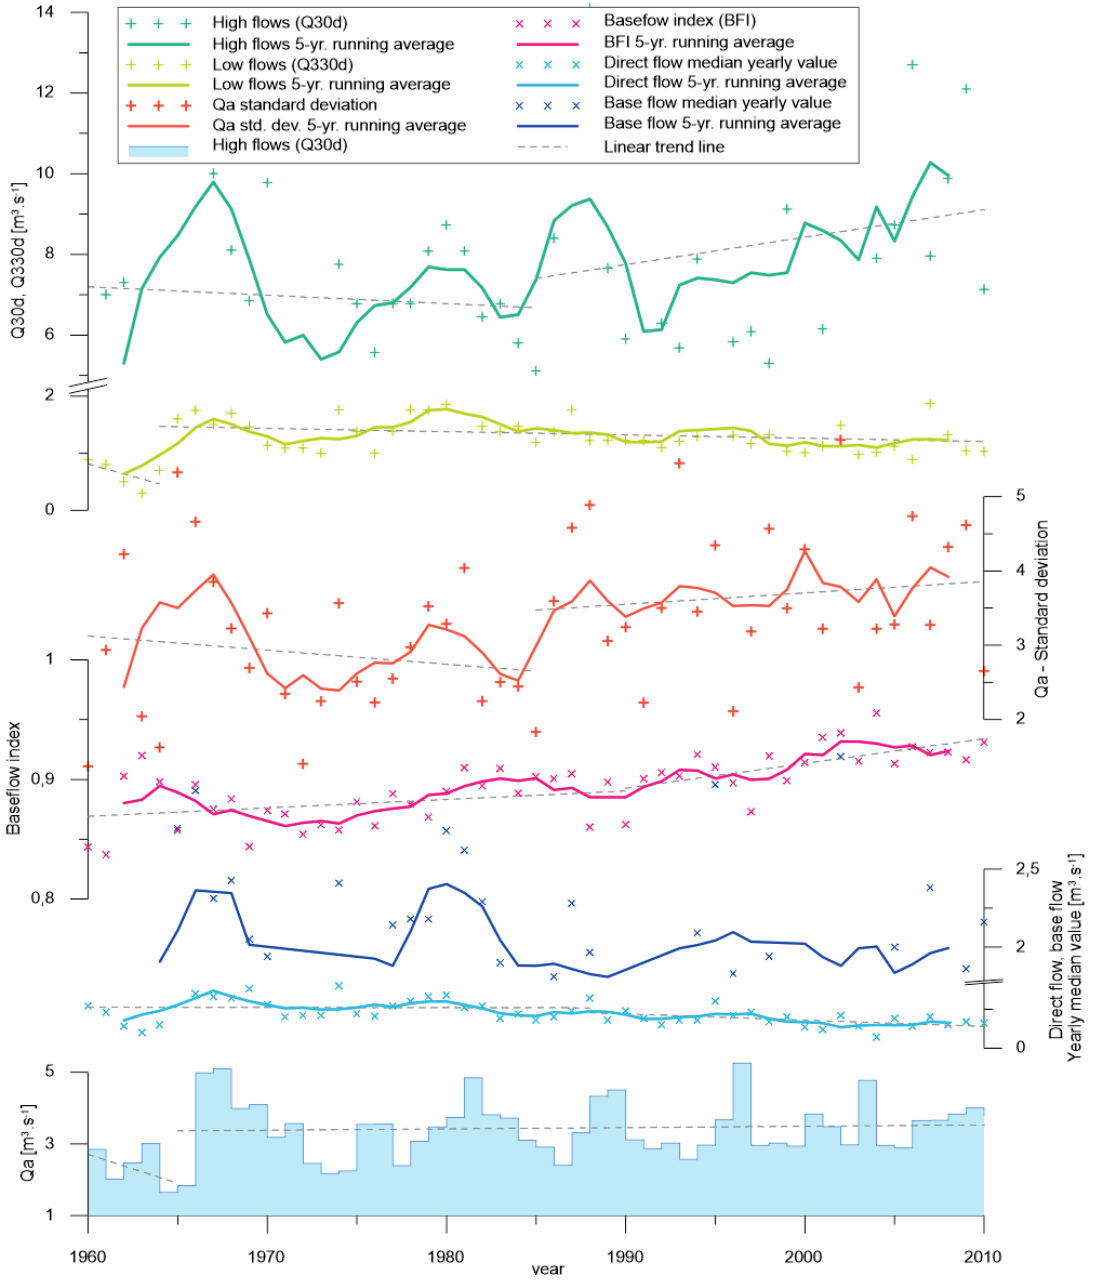
Figure 6. Annual mean values of the direct flow and baseflow index (BFI), high flow (Q 30d ) and low flow (Q 330d ), mean annual discharge (Q a ) and its standard deviation in the period of 1961–2010. The trend lines are based on results from Table